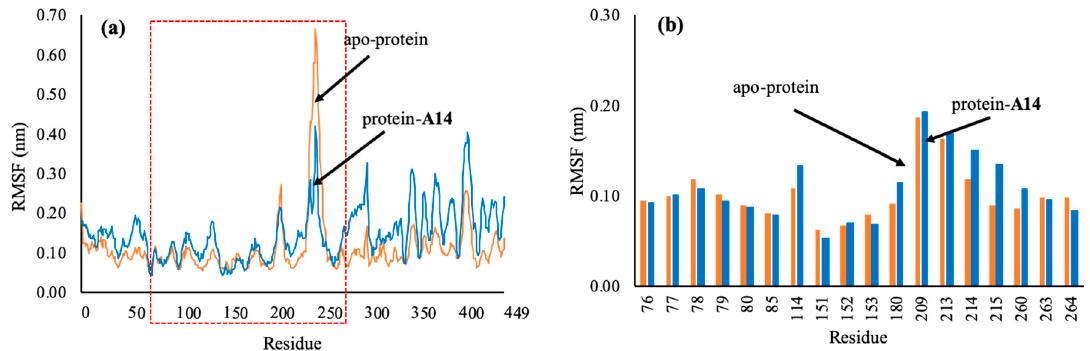
Figure 11. Root mean square fluctuation (RMSF) values of protein 1LPB during 50 ns MD simulations: ( a ) RMSF values of amino acids of protein 1LPB; ( b ) RMSF values of key residues in the active site of protein 1LPB. The protein- A14 complex and the apo-protein 1LBP were showed in blue and orange, respectively.